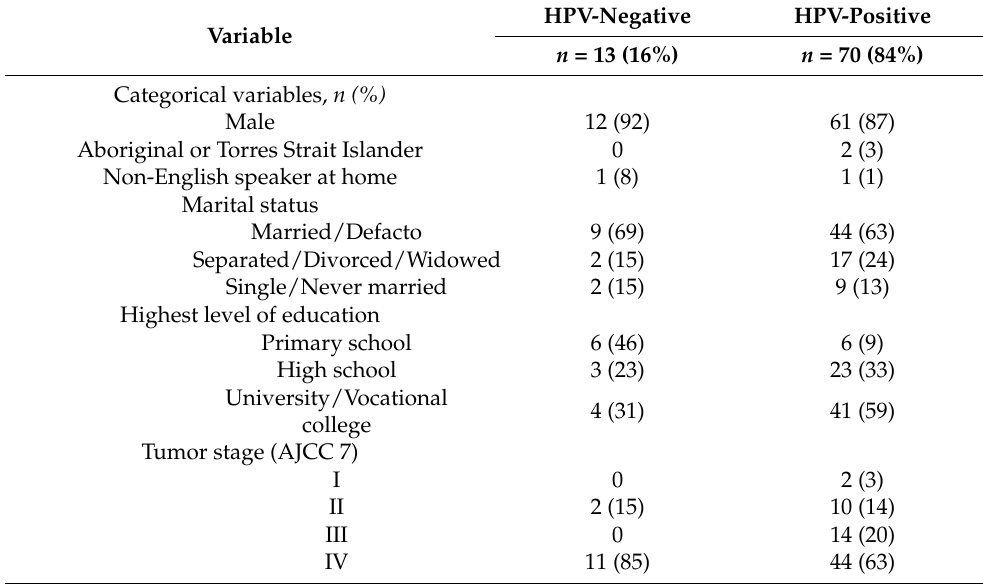
Table 1. Patient characteristics at